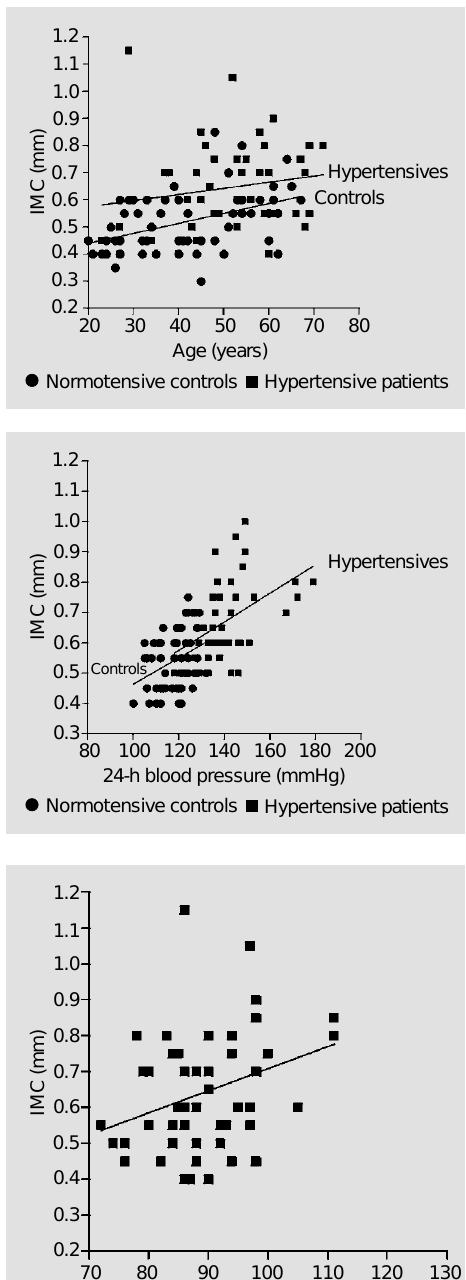
Figure 4 - Correlation between common femural intima-media complex (IMC) and 24-h